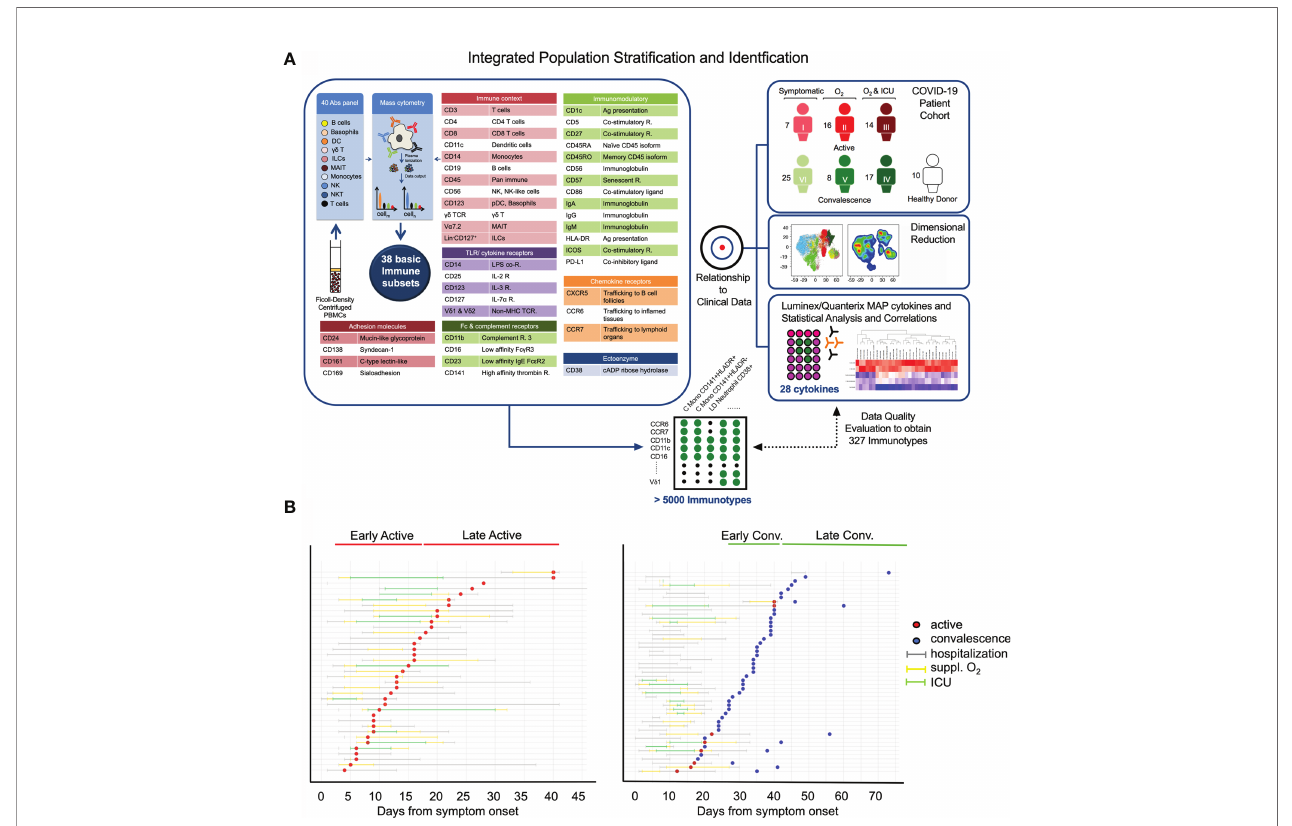
FIGURE 1 | Study design and clinical characteristics of the cohort. (A) Schematic showing the pipeline for sample acquisition and analysis. A list of the antibody targets is presented. (B) Timelines for individual COVID-19 cases, indicating points of sample collection and any clinically pertinent detail e.g. duration of hospitalization, oxygen supplementation and admission to the intensive care unit (ICU). Patients are grouped as a function of days post illness onset (PIO) – d9 (early active; median: 9 days PIO), d20 (late active; median: 20 days PIO), d25 (early convalescence; median: 25 days PIO), d39 (late convalescence; median: 39 days